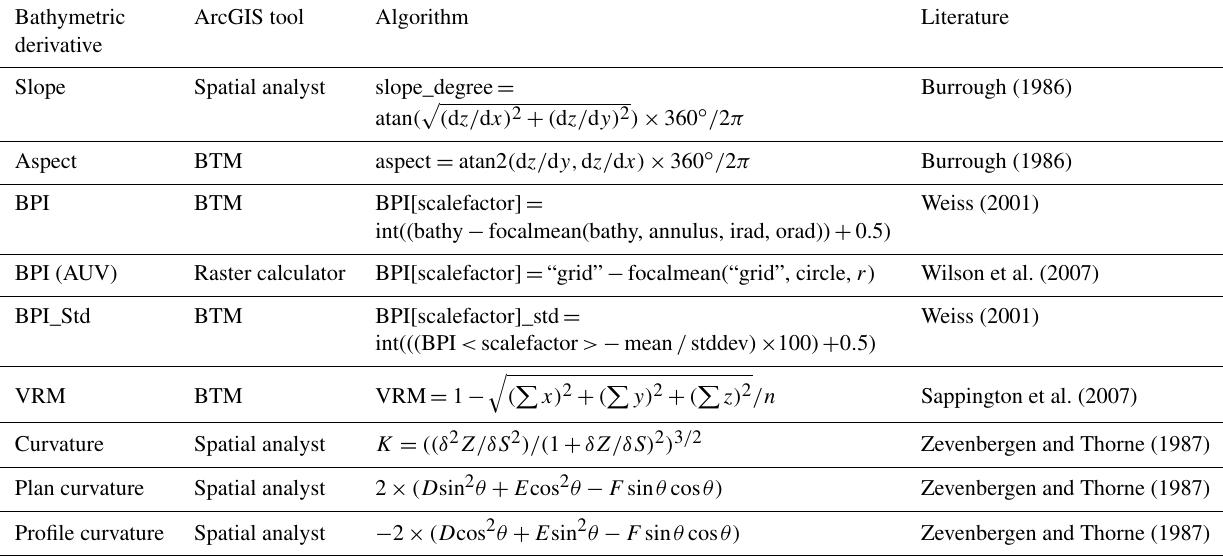
Table A4. Algorithms and ArcGIS tools applied for the calculation of the bathymetric derivatives.